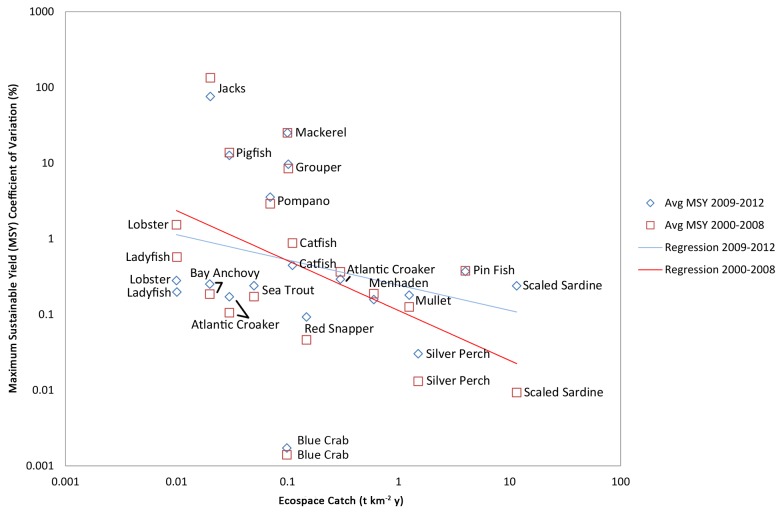
Accuracy of assessment model versus total catch by functional group.This figure illustrates the discrepancy (coefficient of variation) of Maximum Sustainable Yield (MSY) estimated between the (assessment) Pella-Tomlinson model and (operating) Ecospace model based on 2000 to 2008 data (red squares and regression line) and 2009 to 2012 data (blue diamonds and regression line). Catch quantities are as indicated by the Ecospace model from Walters et al. (2008). In general, exploited functional groups towards the top of the figure should be assessed by FIM programs with greater rigor and accuracy than other functional groups, as these functional groups have the highest coefficients of variance. Both regression line slopes were significantly different from zero (t-test: 2000 to 2008 P-value = 0.02, 2009 to 2012 P-value = 0.05), and from one another (t-test: P = 0.01).